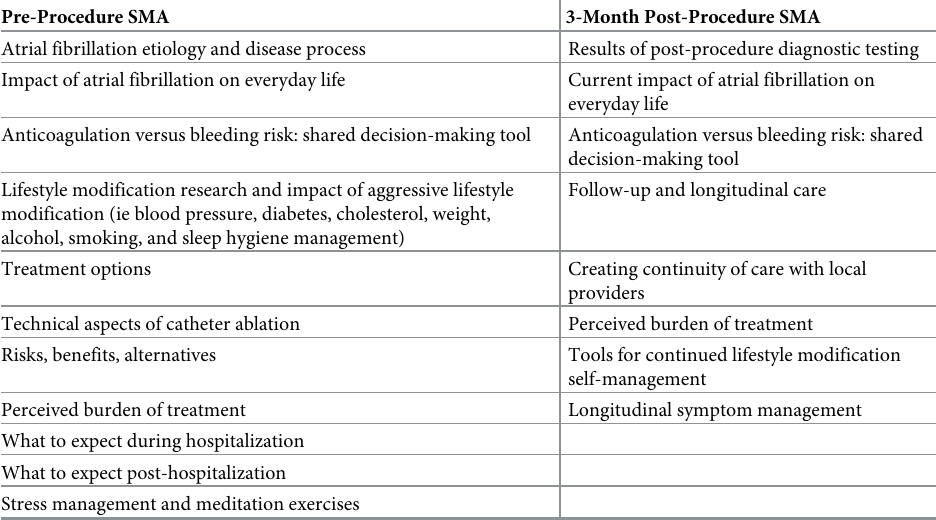
Table 1. Topics discussed during the shared medical appointments for a cardiac ablation pre-procedure and post- procedure